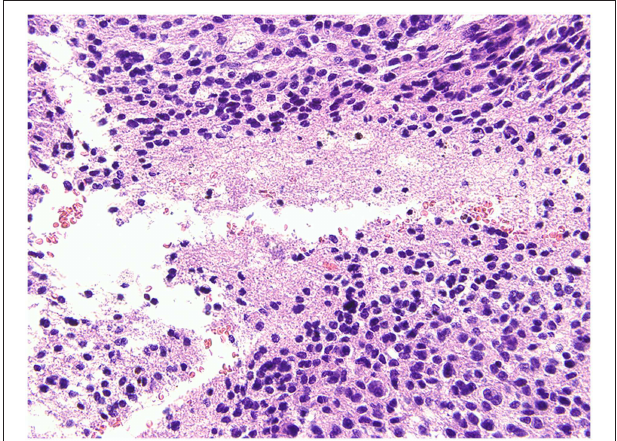
FIGURE 7 | Histological analysis. The pathological report gave a diagnosis of glioblastoma, WHO IV, without mutation of the isocitrate dehydrogenase 1 (IDH1)